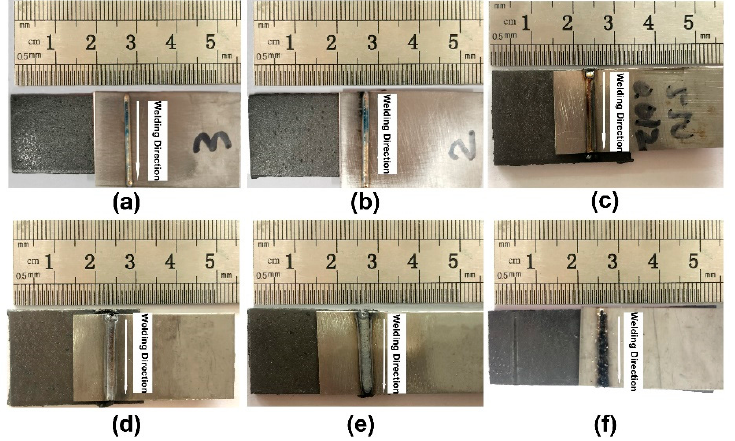
Figure 2. Weld morphology of titanium alloy at different welding speeds with welding power of